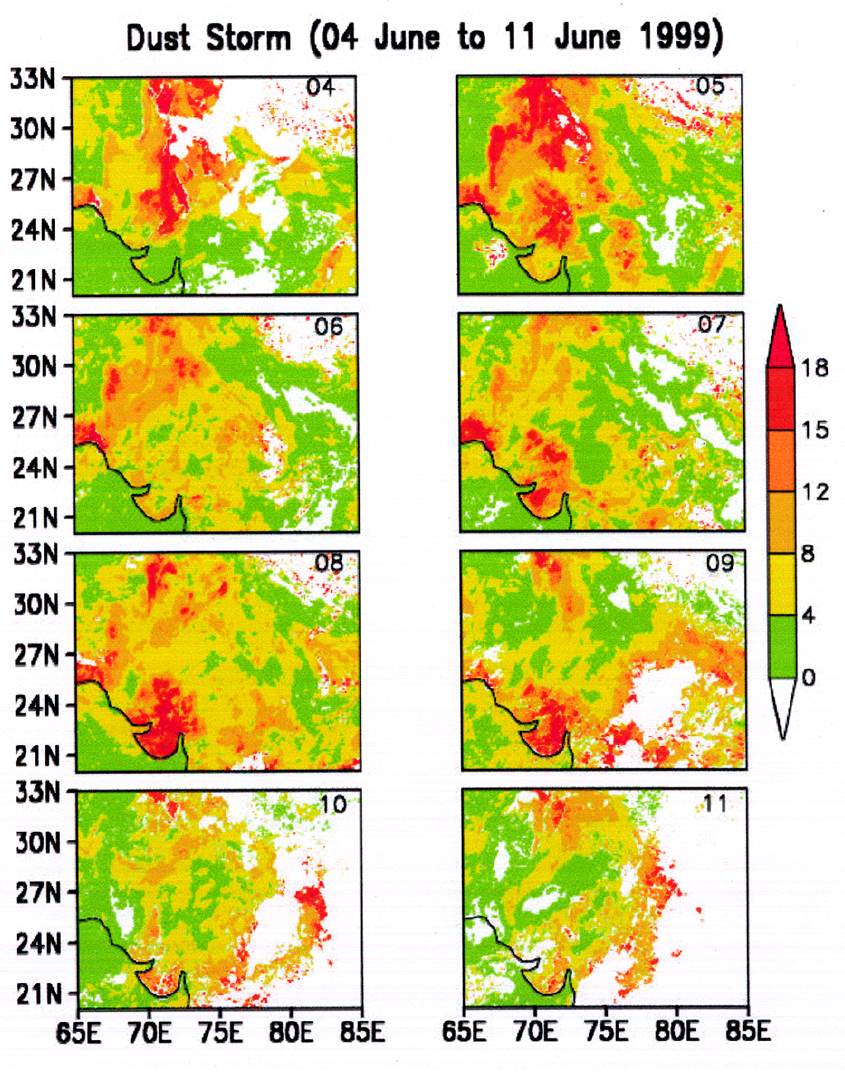
Fig. 16. A typical example of a dust storm observed during June 1999. Here IDDI is in